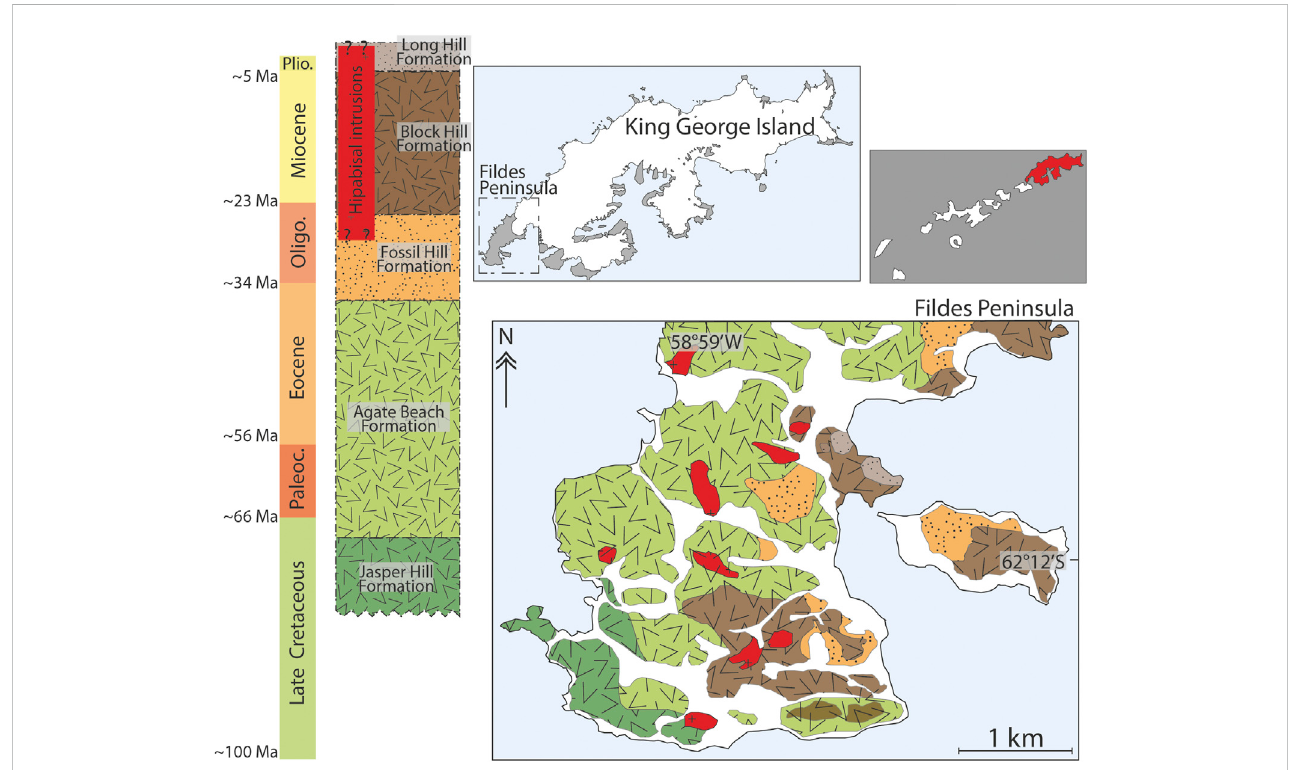
FIGURE 10 Geological map of the Fildes Peninsula, King George Island, modi fi ed from Li et al. (1996).